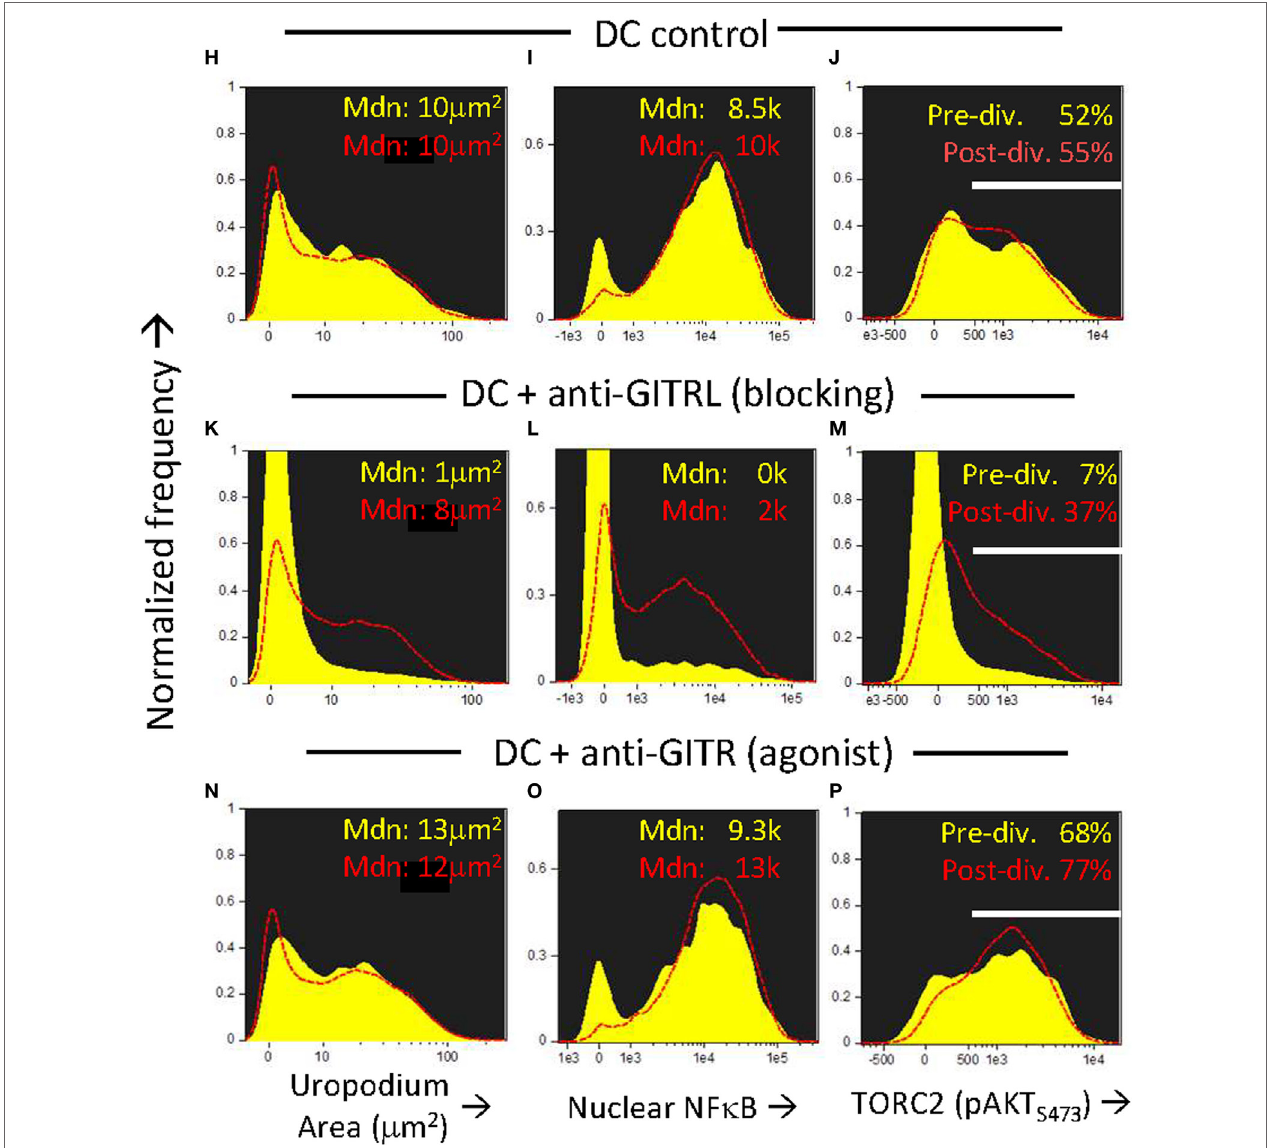
FigUre 10 | Uropodia development before first cell division depends on GITR signaling through mTORC2 and NF κ B. (a–F) Cell trace violet (CTV) labeled female A1RAG CD4 + T cells were stimulated in the presence of IL-2, TGF β , and ATRA with either bone marrow-derived dendritic cells (bmDC) + 100 nM Dby peptide (red, dashed histograms), CD3/CD28 beads (blue lines), or different concentrations (0.1 µg/ml, white lines; 1.0 µg/ml, green lines; or 5 µg/ml, yellow lines) of anti-CD3 antibody coated on the tissue culture plastic, each concentration plus 1 µg/ml anti-CD28 (37.51) in solution. In panels (D–F) an agonist antibody to GITR